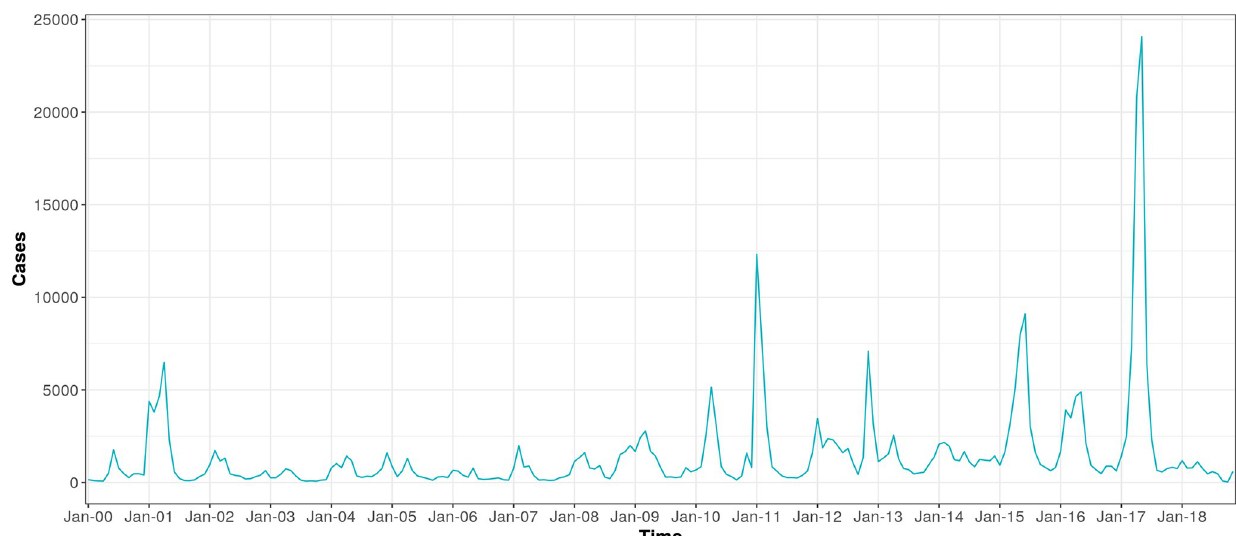
Fig 6. Dengue cases, summed over districts (n = 701), January 2000-September 2018.